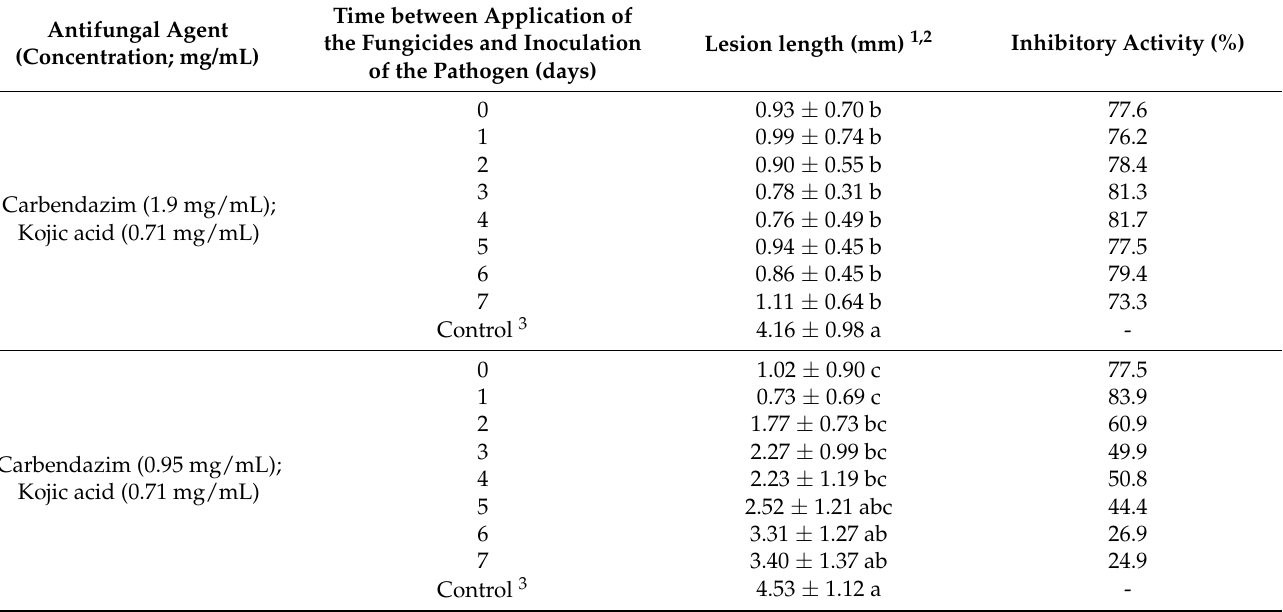
Table 3. Preventive efficacy of carbendazim and kojic acid combinations for the control of Fusarium sulawense on soybean pods at different time